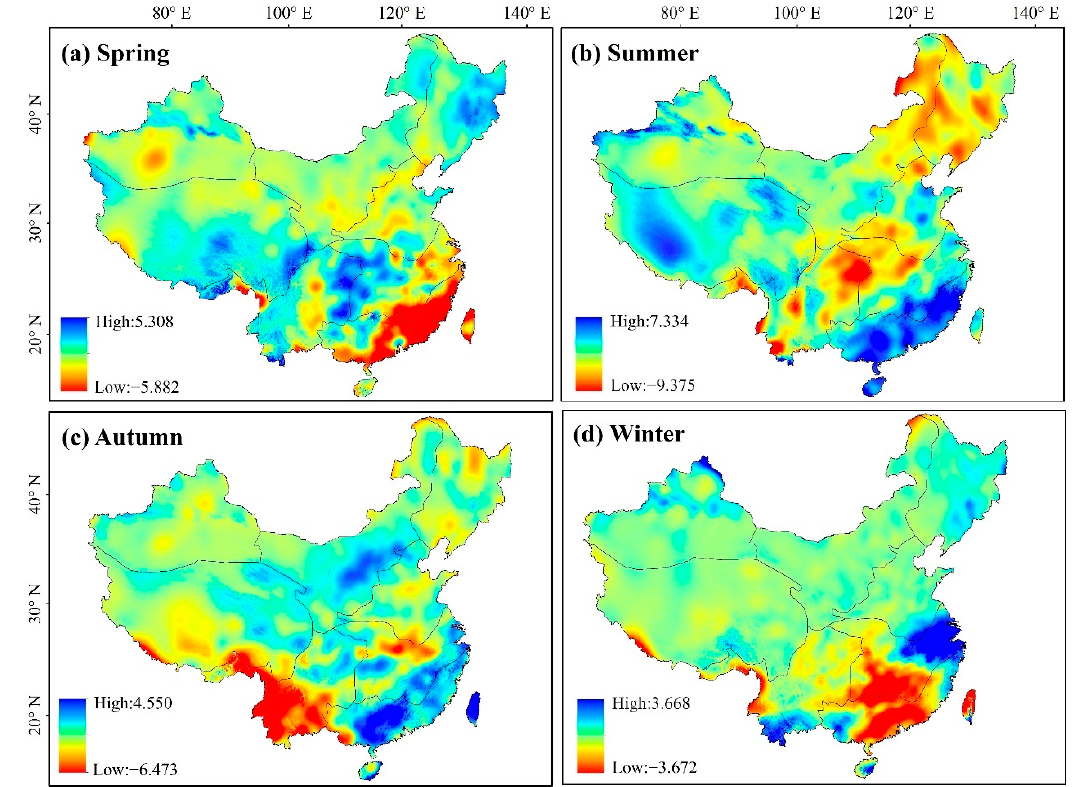
Figure 10. Spatial distribution of seasonal variation trend of precipitation from 1982 to